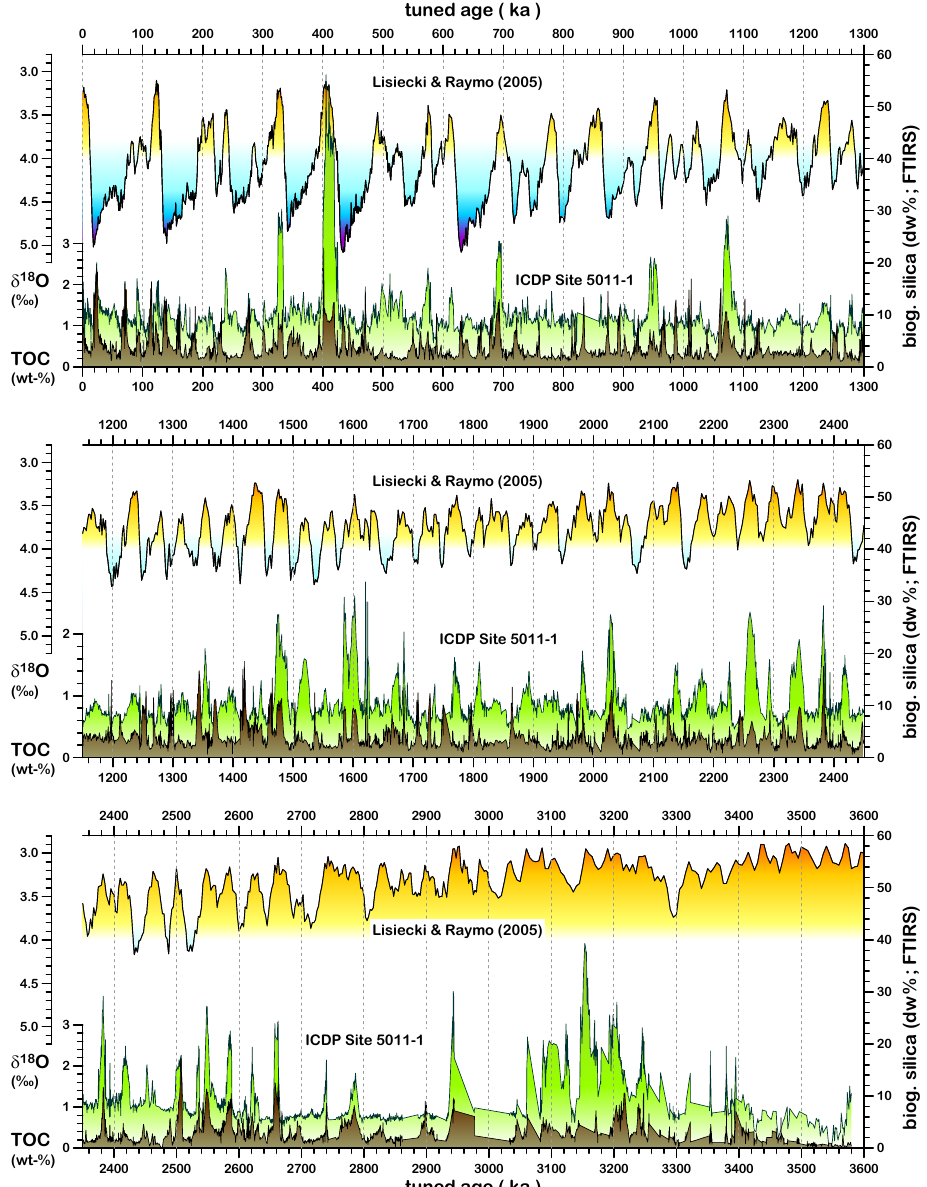
Fig. 10. Response of Lake El’gygytgyn (ICDP Site 5011-1) to climate variability as represented by the marine oxygen isotope ( δ 18 O) stack LR04 (Lisiecki and Raymo, 2005): Time series of (a) biogenic silica (FTIRS estimation), representing bioproductivity in the upper water layers of the lake, and total organic carbon (TOC), representing preservation of organic matter at the lake floor during phases of anoxic bottom waters, (b) Ti content (XRF counts), taken as a proxy of lithogenic input from the catchment, and magnetic susceptibility (MS), representing preservation of magnetic particles during phases of oxygenated bottom waters, (c) hue angle (colour) and Si/Ti ratio, both following global climate cycles. Curves in (a) and (b) were plotted in a way that TOC (MS) superimposes biogenic silica (Ti) in time intervals when best preservation of organic matter (magnetic particles) can be assumed during anoxic (oxic) conditions at the lake floor. Where the TOC curve lies below the biogenic silica curve in (a) , partial degradation (60 to 80%) of organic matter is indicated (green area between both curves). Where the MS curve lies below the Ti curve in (b) , fairly massive dissolution (up to 95%) of the magnetic fraction in the sediments is indicated (grey area between both curves). For further explanation see discussion in the